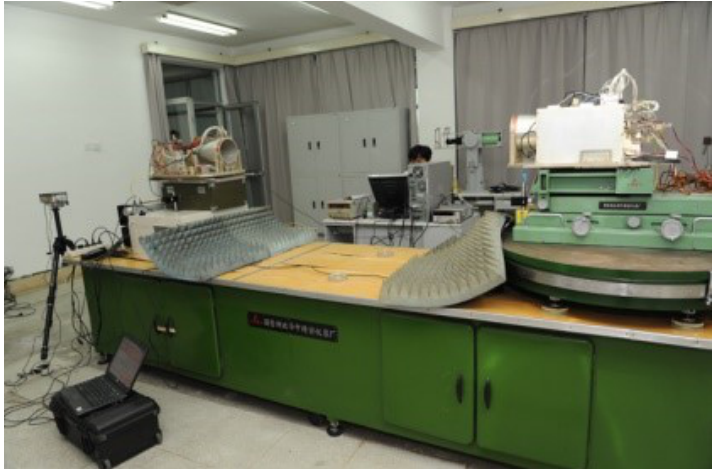
Figure 7. Six degree of freedom moving platform that achieved micron-level accuracy in position and an accuracy of milliarcseconds in attitude